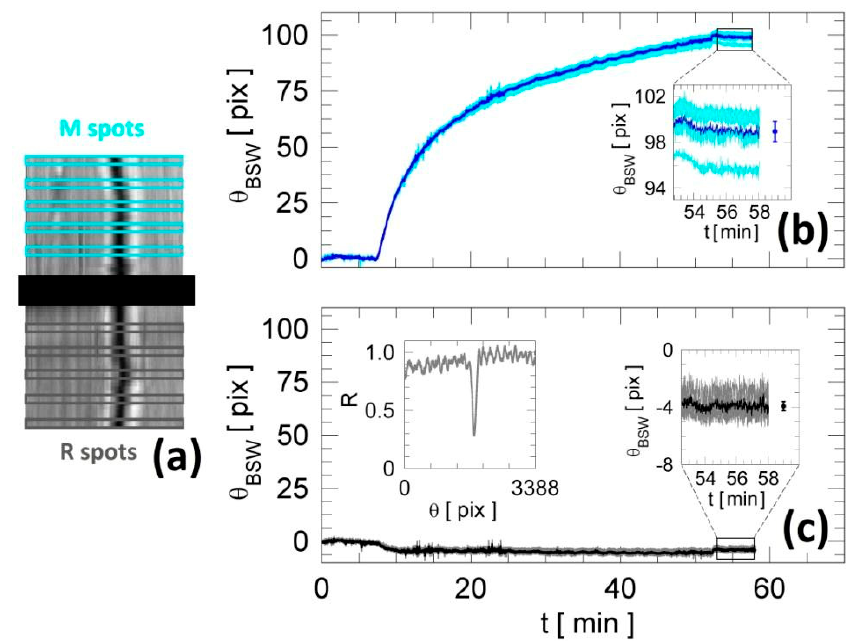
Figure 3. ( a ) 2D reflectance map through the CCD camera and definition of the five sensitive spots for both M and R regions. ( b ) Label ‐ free angular spread on five adjacent spots in the measurements (IgG) and ( c ) reference regions (Anti ‐ Ova) after analyte (Anti ‐ IgG) interaction. The blue and black lines correspond to averaged curves from measurement and reference regions, respectively. In the zoomed areas, the points are the mean values with standard deviation for the five label ‐ free residual angular shifts. In the inset of ( c ), an experimental reflectance is shown for one of the reference spots.